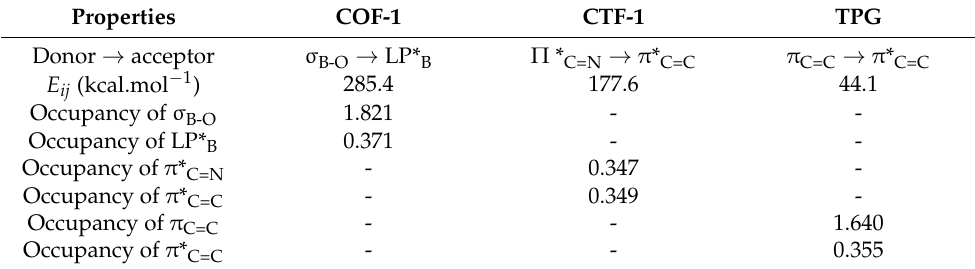
Table 2. Second-order perturbation theory analysis and occupancy of natural orbitals (NBOs).